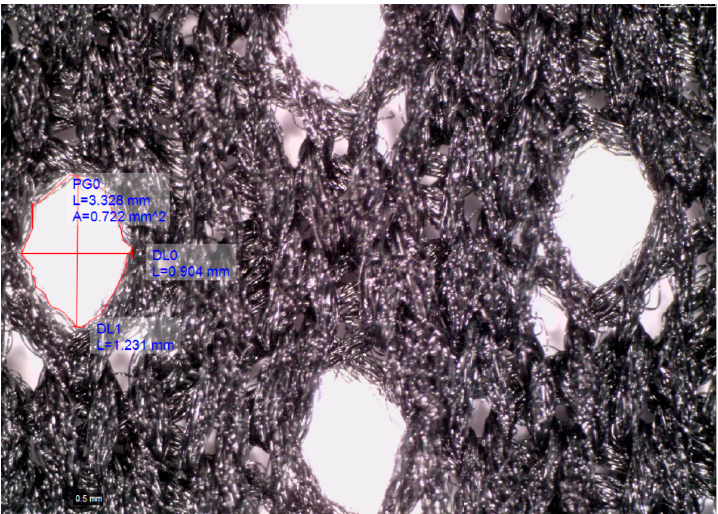
Figure 1. Topographic characterization in